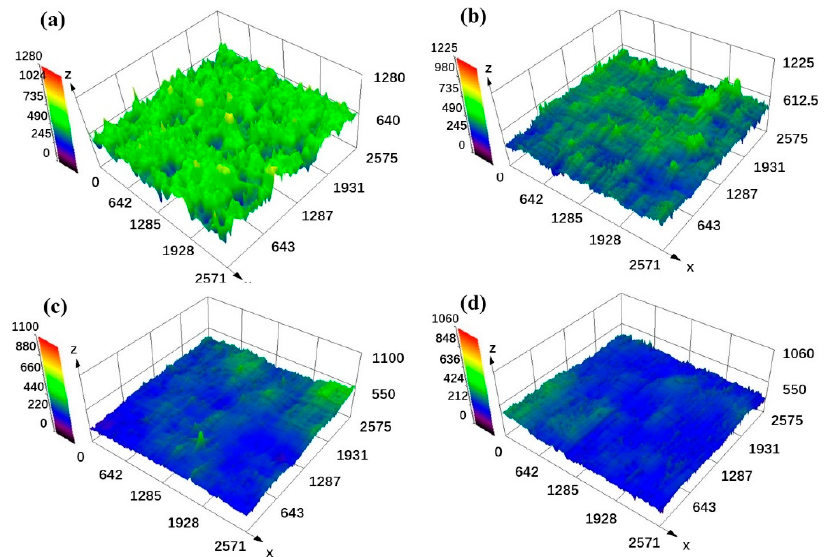
Figure 8. The three-dimensional surface morphology of the cemented carbide blocks formed under different process parameters, ( a ) 95 W, 500 mm/s, scan I; ( b ) 125 W, 370 mm/s, scan I; ( c ) 215 W, 370 mm/s scan I; ( d ) 215 W, 370 mm/s, scan II.